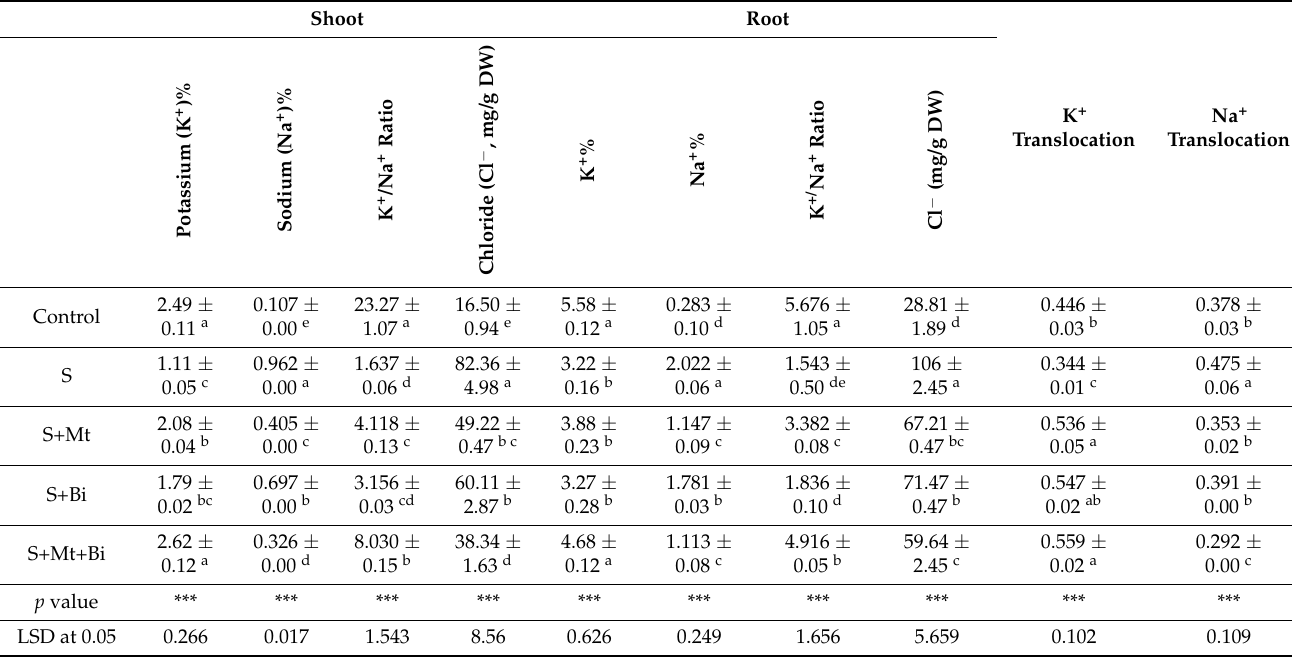
Table 2. The effect of melatonin (Mt) and/or biochar (Bi) supply on some ions of borage plants grown in a saline medium (S, 5000 ppm NaCl).